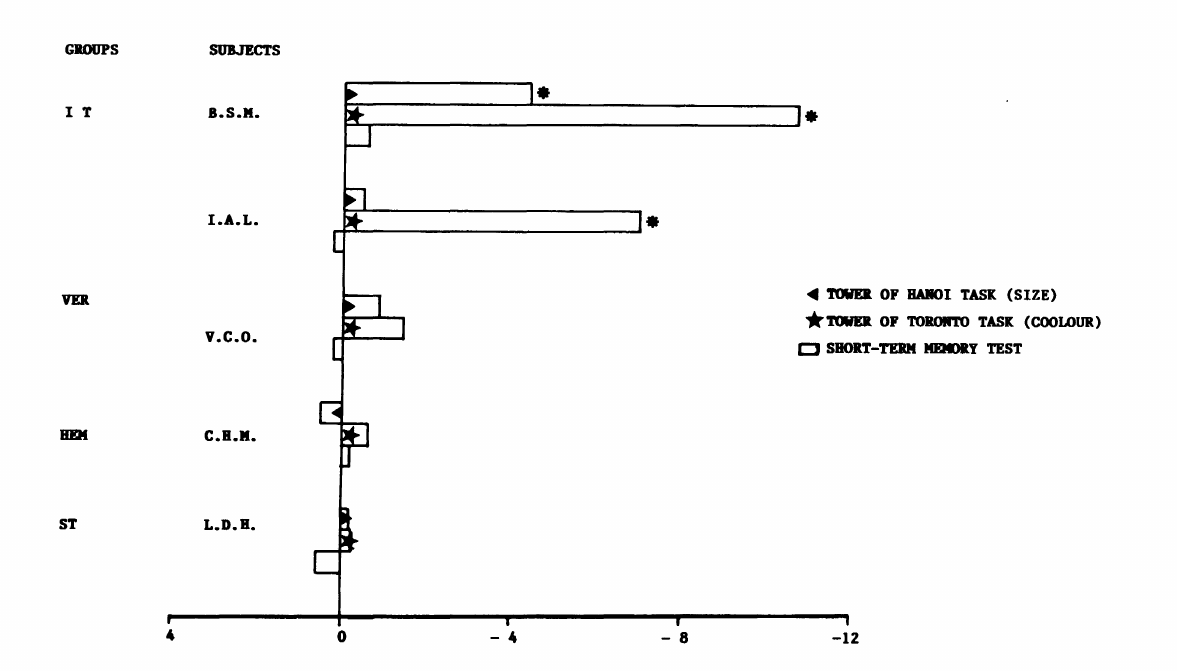
FIG. 5. Differences in the procedural learning tasks, in comparison with those obtained in the short-term memory test, between individual patients' scores and the control subjects' scores plotted in terms of S.D. units. A difference between patient and control means was considered significant (*) when it fell more than 2.6 S.D.s (P<O.01) beyond normal values. Note that scale proportions here are larger than in Fig.